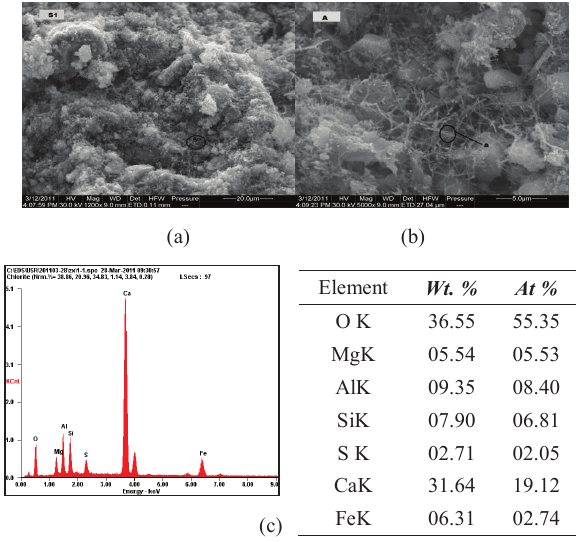
Figure 9: SEM- energy spectrum of S1 hydration products in sludge. When the Slag sludge-based curing agent ratio was S1 [(steel slag: Activator): fluoride gypsum = (90%: 10%):2.5%], the sludge water content showed the most marked decrease; A 20% addition of S1 with curing at 20+1°C for 7day s, have enhanced the physicochemical properties of S1 solidified sludge to the standard of landfill (GB/T 23485-2009). The